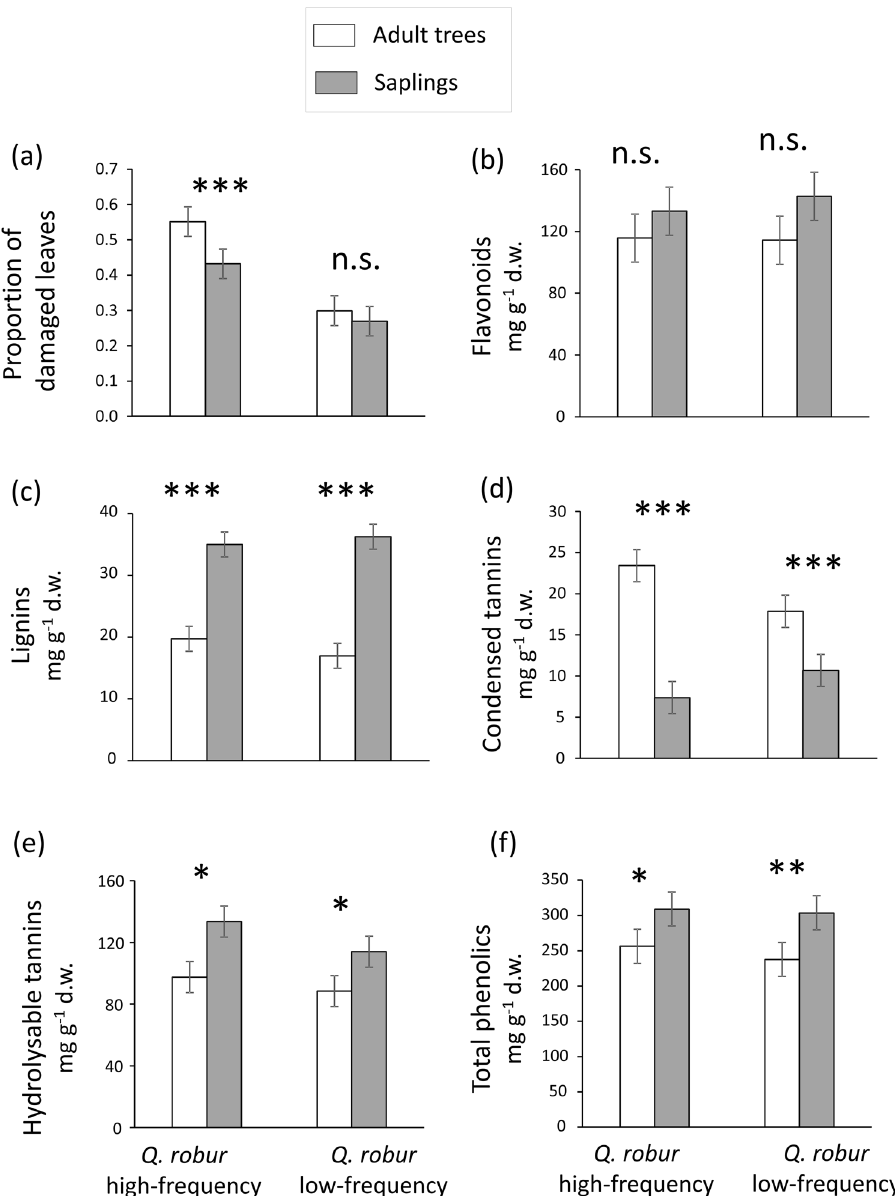
Figure 1. Effect of plant neighbourhood composition and ontogeny on herbivory and plant chemical defences in Quercus robur . ( a ) Proportion of leaves damaged by insect herbivores, and concentration (mg g − 1 d.w.) of leaf ( b ) flavonoids, ( c ) lignins, ( d ) condensed tannins, ( e ) hydrolysable tannins, and ( f ) total phenolics for adult reproductive trees (white bars) and saplings (grey bars) growing in Q. robur high-frequency and low-frequency stands. Bars are least square means ± standard error (N = 60). Asterisks indicate significant ontogenetic differences within each Q. robur stand type at P < 0.05 ( * ), P < 0.01 ( ** ) and P < 0.001 ( *** ). n.s. =